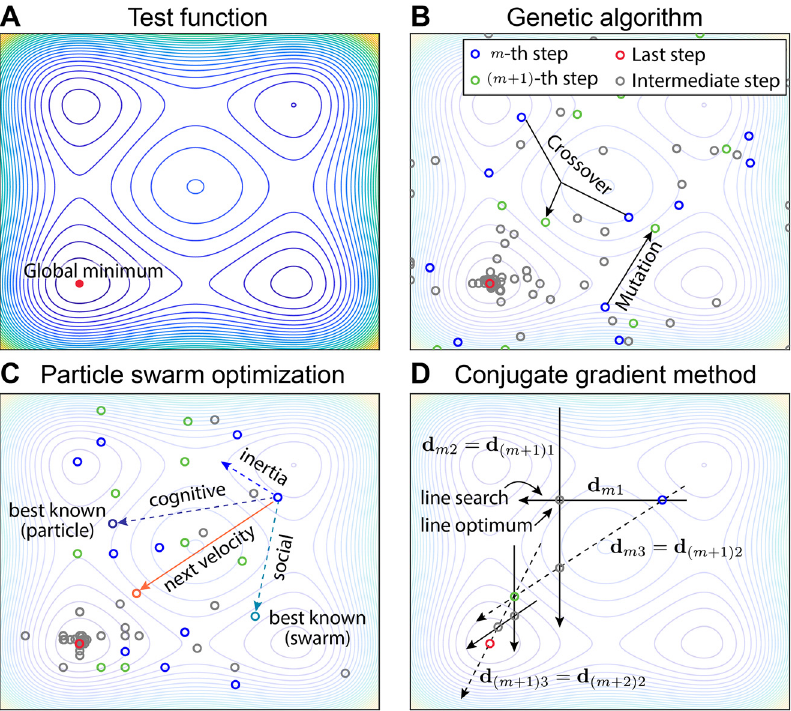
Figure 4: Illustration of classical optimization methods and a test function (Styblinski – Tang) to which the methods are applied. ( A ) Contour plot of test function. Global minimum is indicated as a red dot. ( B ) Schematic of GA applied to the test function. The black arrow merged between two blue circles represents crossover operation. The black arrow from the single blue circle represents mutation operation. For ( B – D ), evaluation points during optimization at current ( m- th), next (( m + 1)-th) and last step are indicated as blue, green, and red circles, respectively. Other intermediate evaluation points are indicated as gray circles. ( C ) Schematic of PSO applied to the test function. Historical best-known particle from a swarm and its own are shown in turquoise and purple circles. The velocity vector representing inertia, cognitive, andsocialtermsareindicatedasblue,purple,andturquoisedottedarrows,respectively.( D )Schematicofconjugatedirectionmethodapplied to the test function. The solid and dotted black arrows indicate the direction of line searches at each corresponding step. The dotted black arrowsrepresentthenewlyaddedsearchdirectionateachcorrespondingstep.Notethatsomeoftheevaluationpointsin( B – D )weremodi fi ed from actual locations, for an illustration